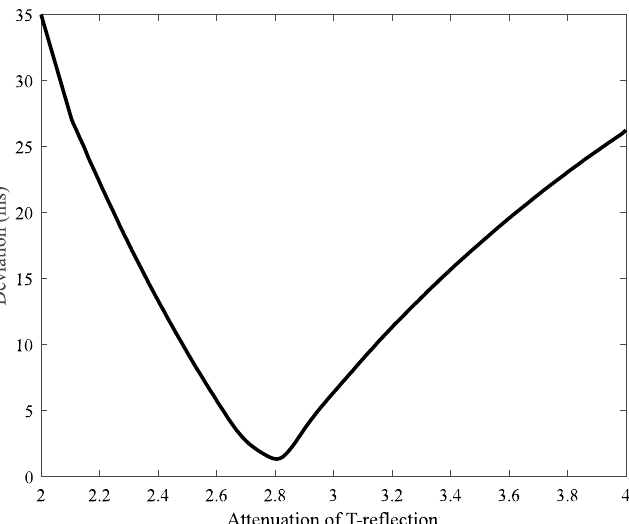
Figure 5. The variation of deviation with the attenuation ratio of